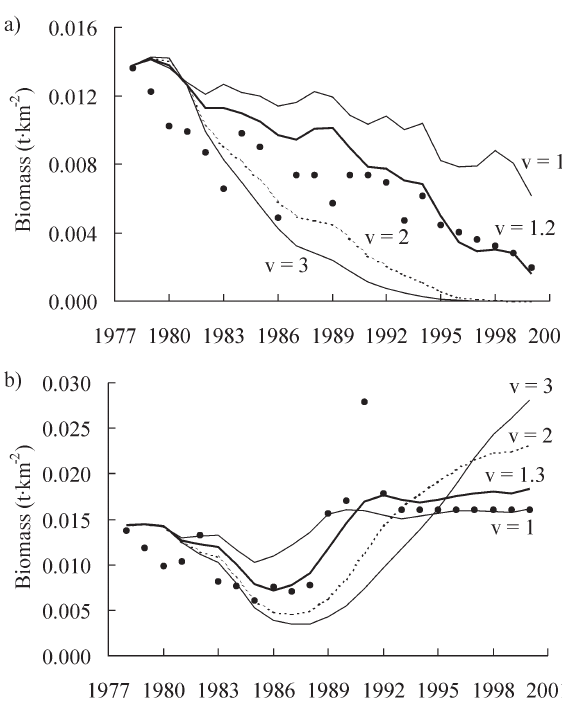
Fig . 3. – Verification of the model: observed time series (dots) of biomass for spiny lobsters (a) and southern red snapper (b) off northeastern Brazil and estimated values from Ecopath with Ecosim under four values of vulnerability ‘v’ (lines) for the period from 1978 to 2000. The thicker line is associated with the vulnerability value used in the final version of the model.